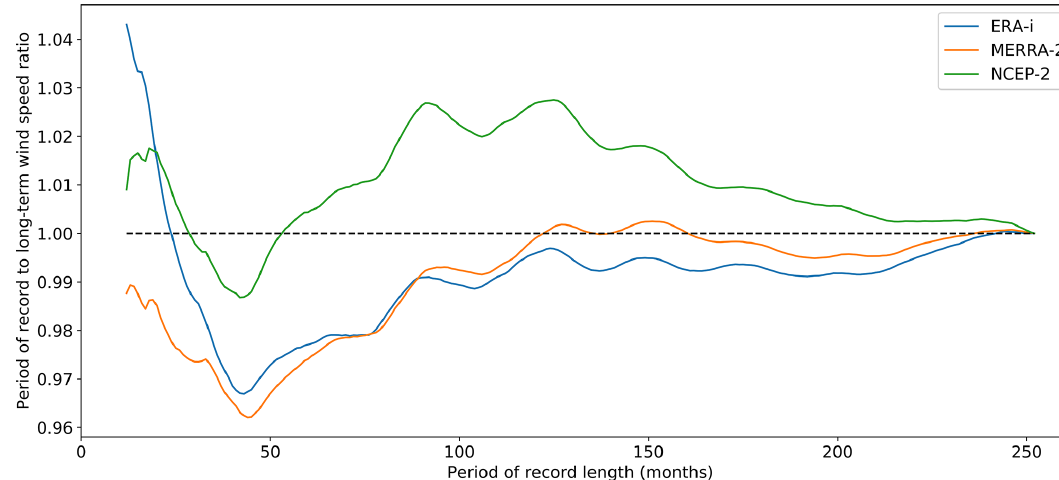
Figure 9. Ratio of wind speed to the long-term, 20-year average for periods of record of different lengths (all ending in December 2017) for EIA station ID 60502 using data from the three reanalysis products in the study.